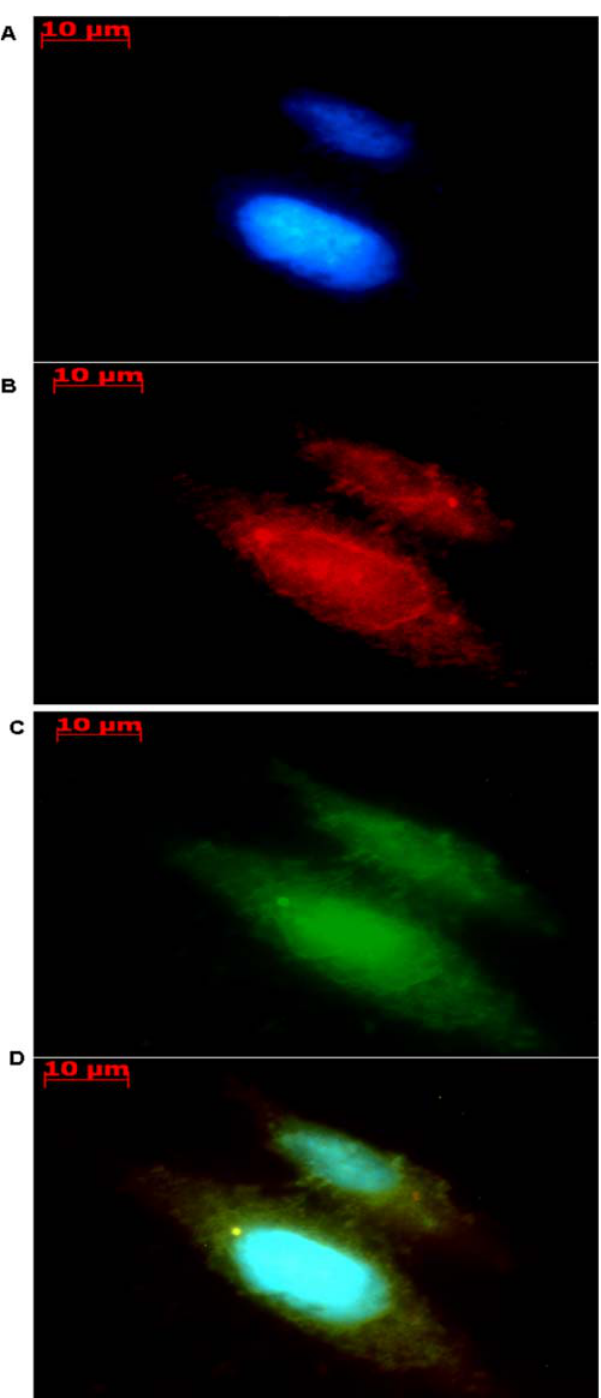
Figure 9. Localization of LDH in the mitochondria. Mitochondria were isolated and separated into A) Mitoplast and B) Outer membrane and inner membrane space fractions. I) Immunoblot for LDH1 in the mitochondrial fractions. II) Immunoblot for Cyt C and SDH to determine purity of mitochondrial fractions. Std corresponds to LDH from porcine heart (Sigma).